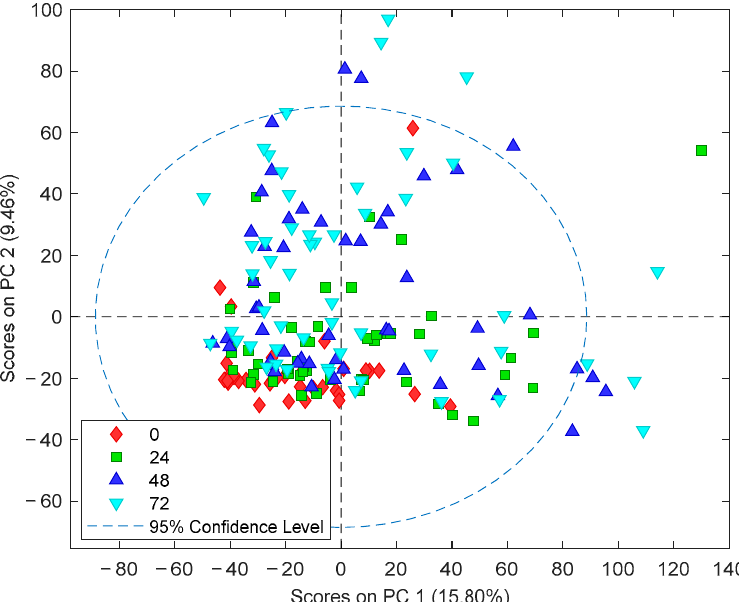
Figure 2. PCA scores plot of plasma metabolomic fingerprints. Note: Blood samples were extracted at birth and at 24, 48, and 72 h after the administration of the first dose of medication/placebo.